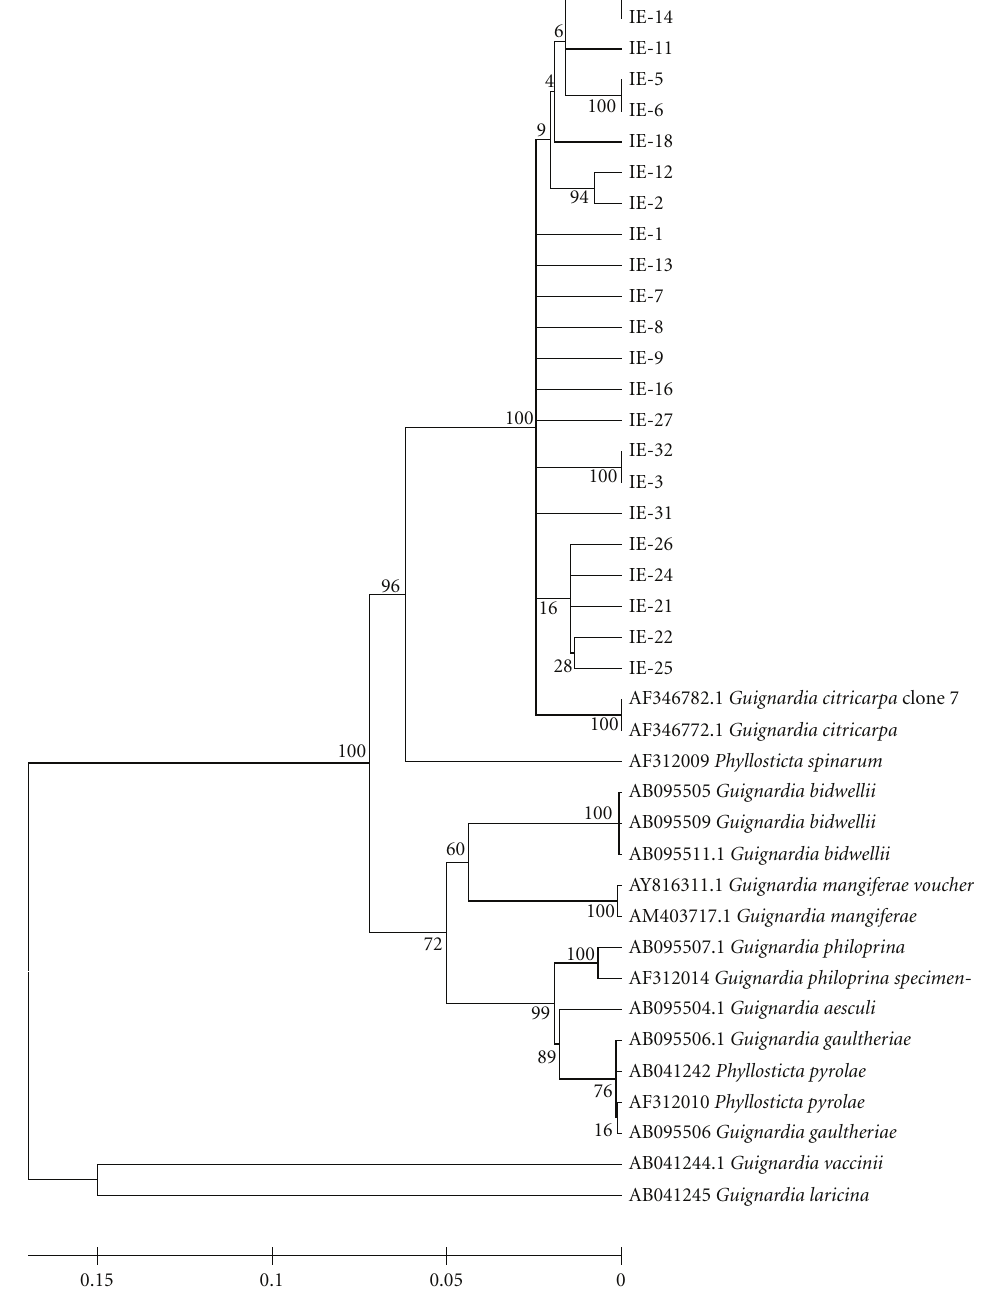
Figure 2: Genetic relationships inferred by ITS1-5.8S-ITS2 DNA sequence from isolates obtained in fruits from a same plant with CBS symptoms of “Valˆencia” variety in Conchal/SP. It can be verified that all isolates show high similarity to each other and with the G. citricarpa sequence obtained in GenBank. High divergence was found with the obtained isolates and GenBank sequences of G. laricina and G. vaccinii